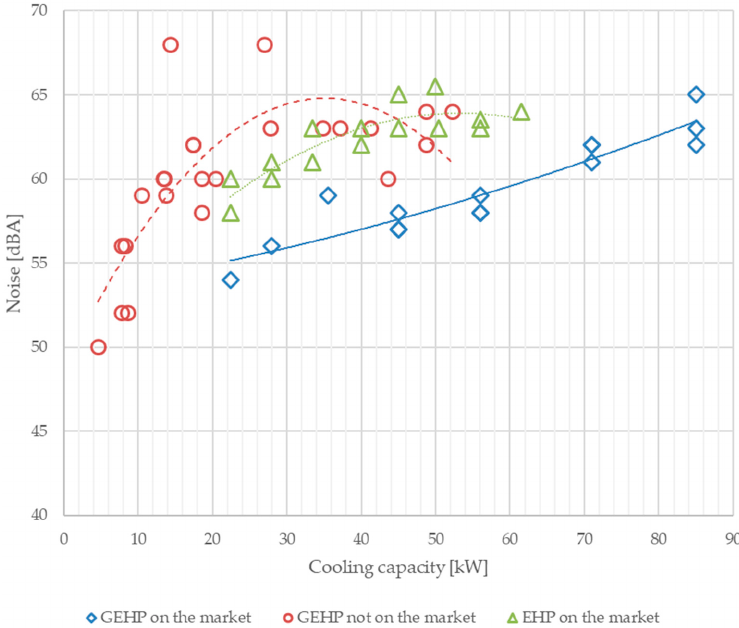
Figure 8. Noise of GEHPs (oldest and newest) and EHPs as a function of cooling capacity.